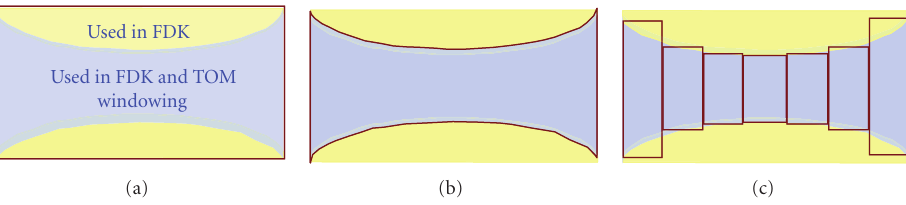
Figure 3: The detector utilization of the FDK-based and TOM windowing reconstruction approaches. The area closed by red lines represents the actual acquired area of the detector for (a) multi-axial scan/line source CT, (b) line source CT curved collimator, and (c) multi-source inverse geometry CT. The area in blue represents the data required to reconstruct volume using TOM windowing approach. Note that TOM windowing has an advantage over FDK in detector utilization if data is acquired by the line-source CT with the collimator or the multi-source inverse geometry CT.